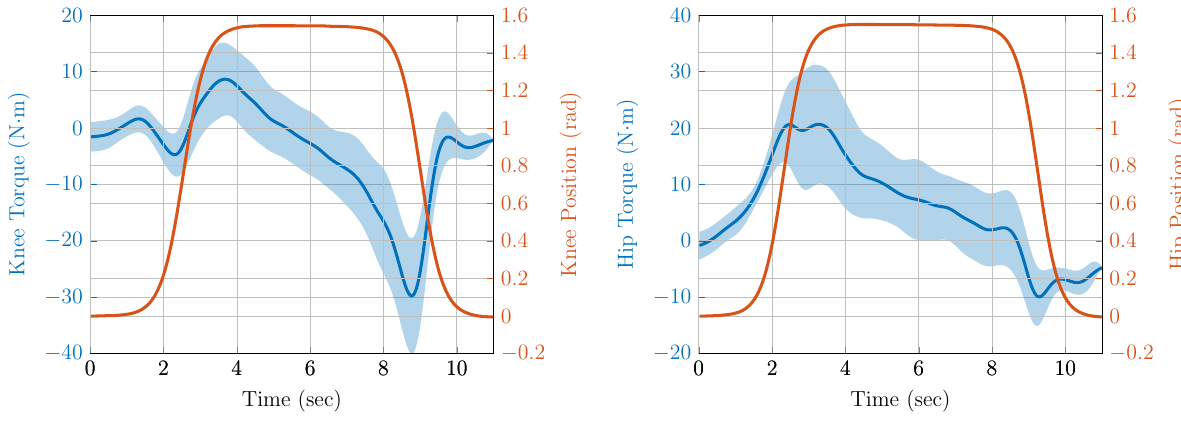
Figure 11. Actuator torques and joint positions measured during the sit-down and stand-up movement task.